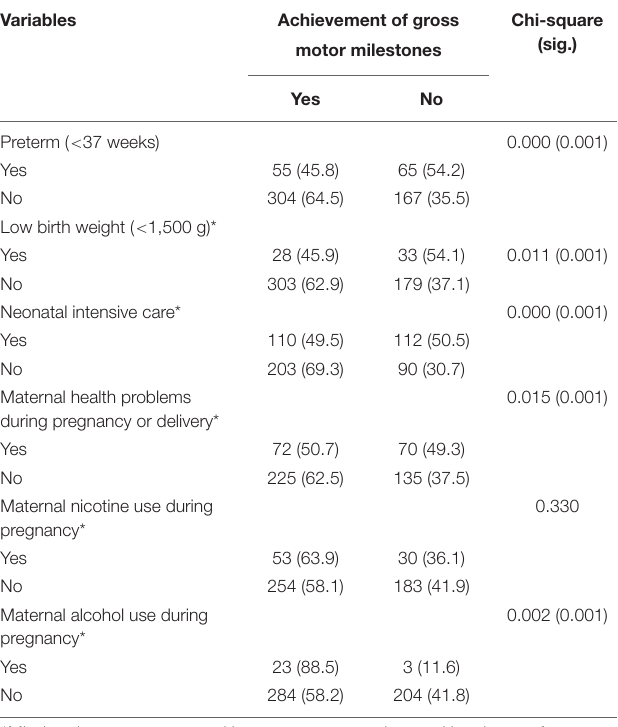
TABLE 3 | Bivariate association between achievement of gross motor milestones and predictors for children 6–47 months ( n = 591). Variables Achievement of gross